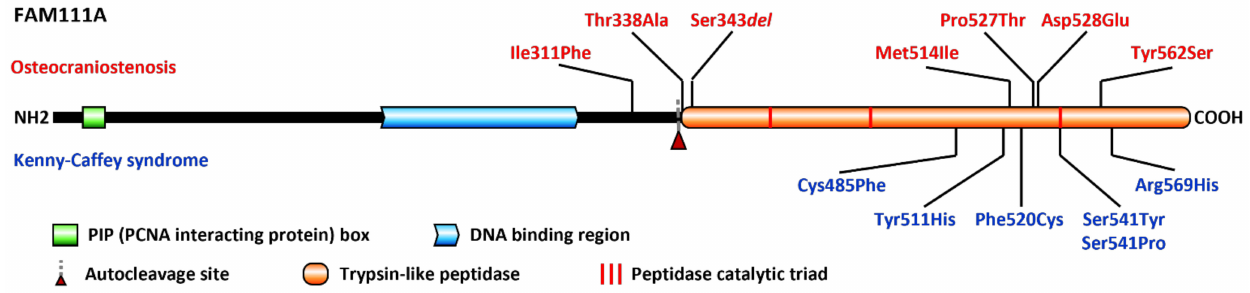
Figure 3. Scheme of the FAM111A protein and known pathogenic variants associated with either osteocraniostenosis (OCS, top ) or Kenny-Caffey syndrome (KCS, bottom ). Cys485Phe was reported in [33], Ser541Tyr/Pro were reported in [5,32], respectively, Tyr562Ser was reported in [21], while all other variants were observed at the Laboratory of Genetics at CHUV ([7] and this report). The domain in orange has homology to trypsin-like peptidases, including an untested catalytic triad purportedly composed of Ser541/His385/Asp439 (red